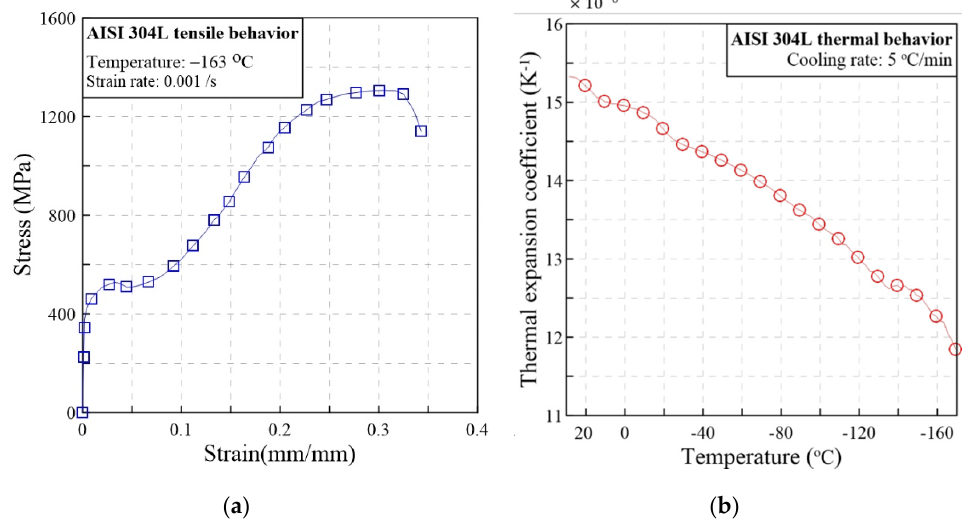
Figure 3. ( a ) Stress–strain curve of AISI 304L tensile test at − 163 °C; ( b ) thermal expansion coefficient of AISI 304L at room and cryogenic temperature. of AISI 304L at room and cryogenic